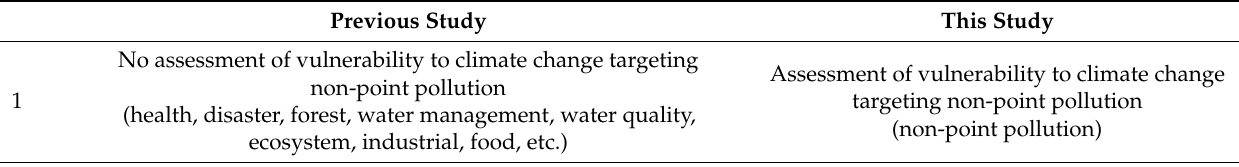
Table 15. Comparing the precision of this study and previous